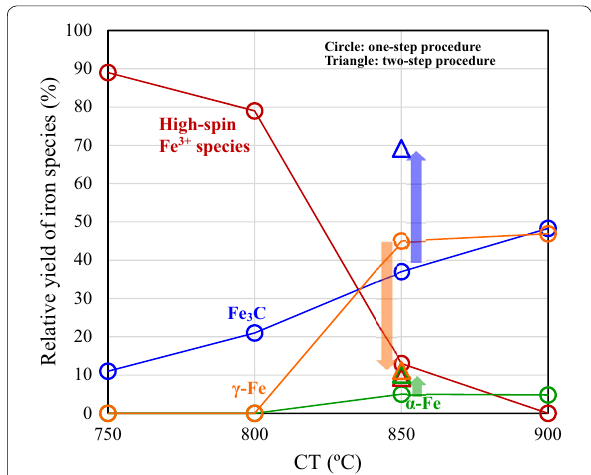
Fig. 4 CT-dependence of iron species yield in charcoal